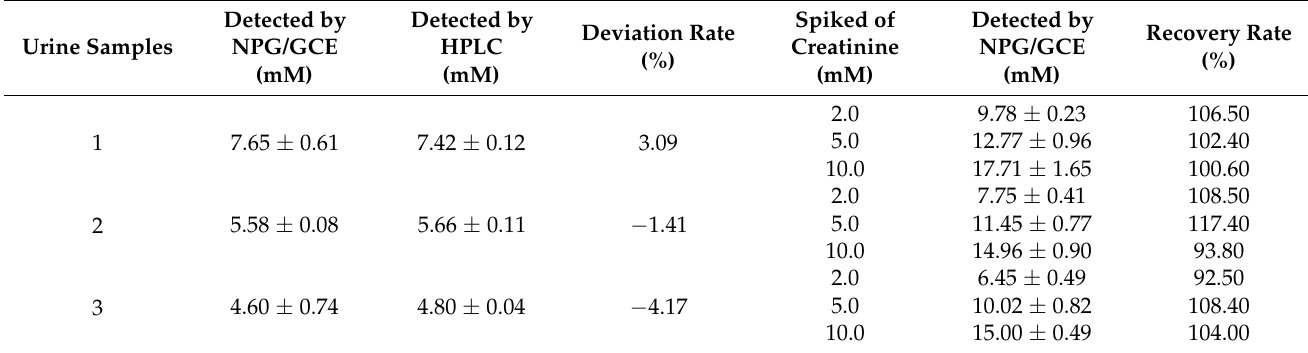
Table 2. The detection of creatinine in human urine